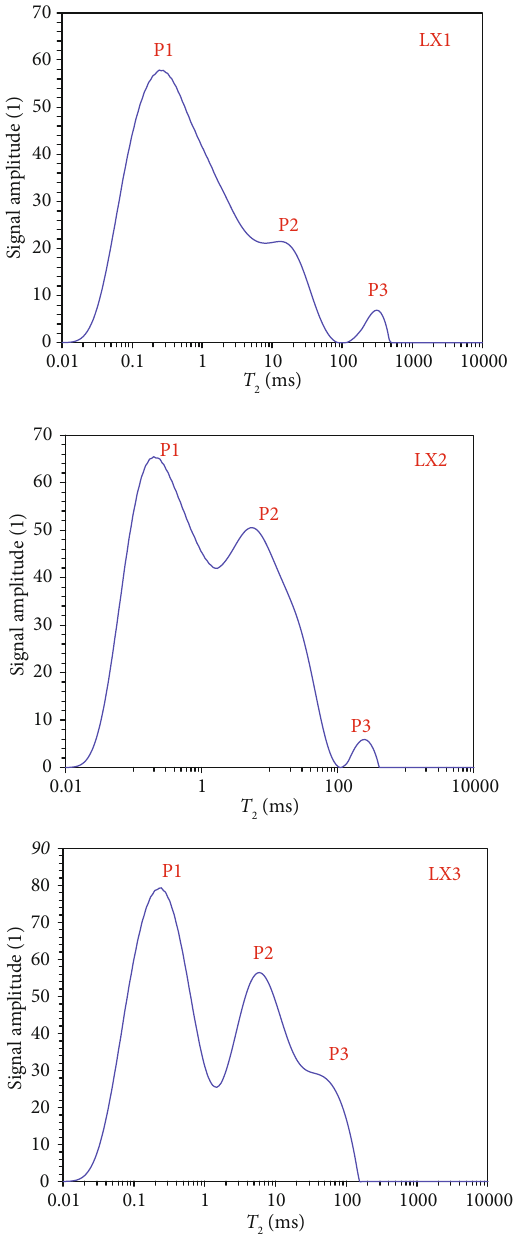
Figure 5: NMR T samples.